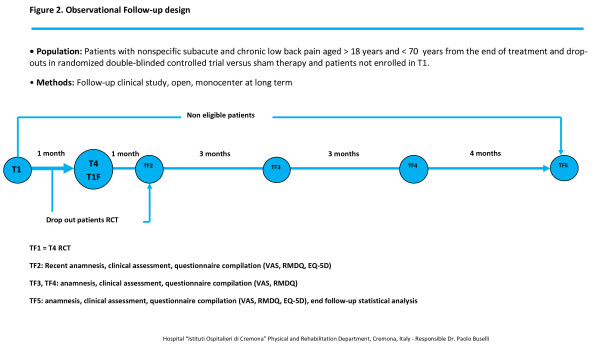
Follow-up Design.